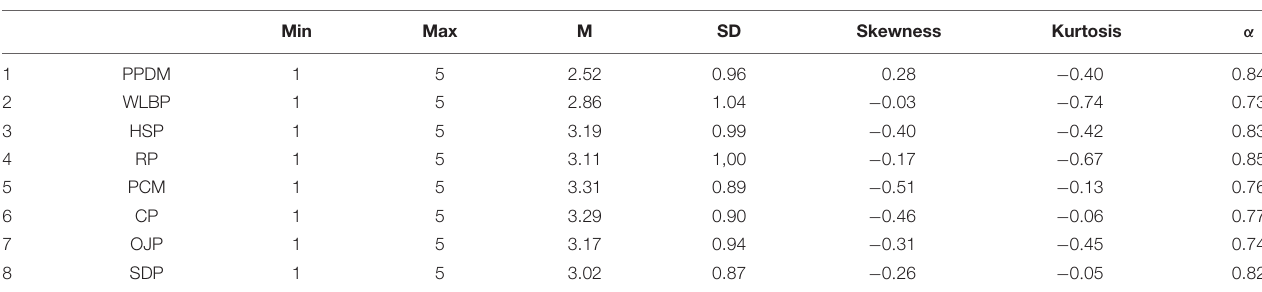
TABLE 4 | Descriptive statistics of the eight subdimensions of VOPi (Study 3).